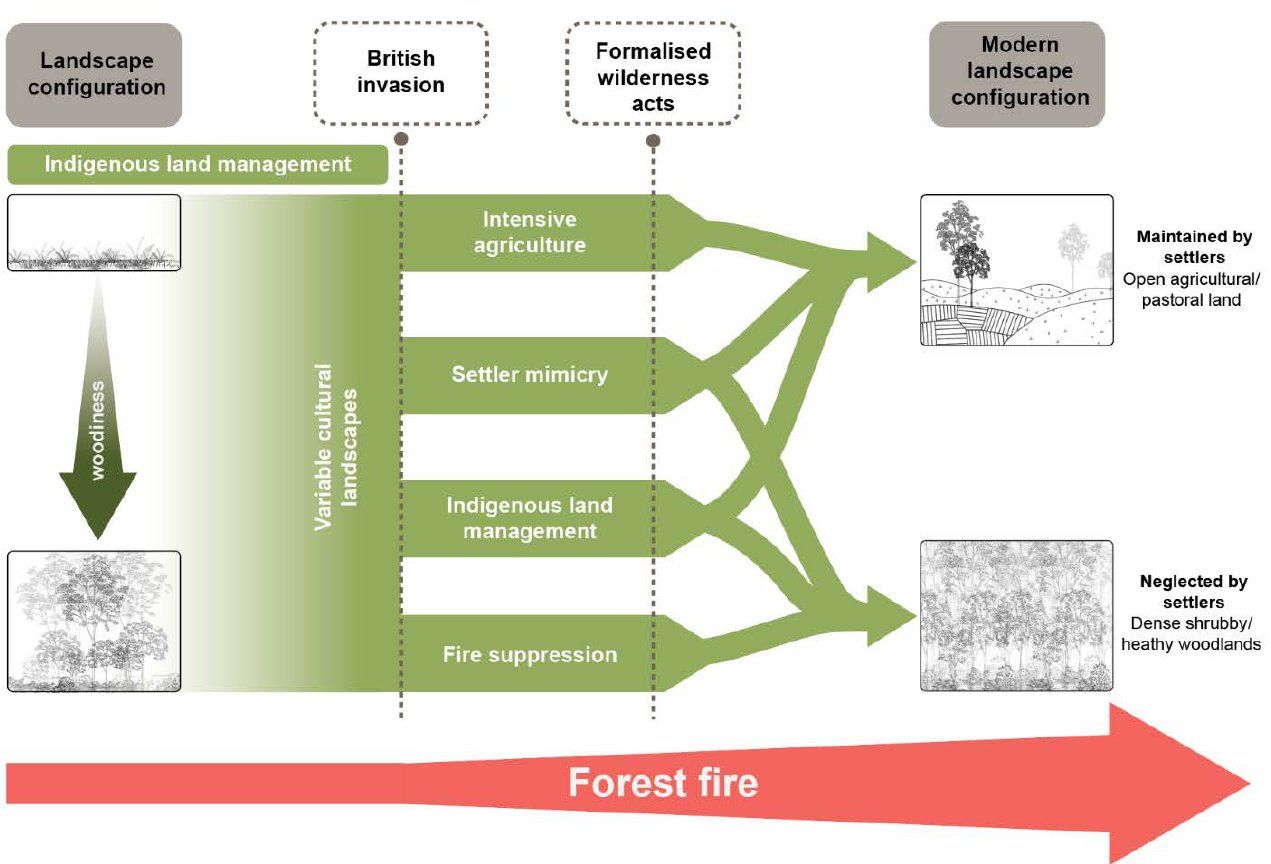
Figure 7. Conceptual diagram of how the landscape configuration and bushfire activity of southeast Australia has changed through time in response to the British Invasion and subsequent wilderness- inspired conservation legislation. Prior to British Invasion, Indigenous people managed variable cultural landscapes with fire across all parts of the region from open grasslands to closed forests in southeast Australia according to cultural protocols and economic objectives (left). After British Invasion management of landscape outside urban areas was fractured into four main approaches: (1) Intensive agriculture (taking advantage of open, grassy landscapes created and managed by Indigenous people, settlers concentrated agricultural activity and opened Country further); (2) Settler mimicry (in less open areas settlers mimicked cultural burning due to the recognition that Aboriginal managed landscapes were safer and more productive); (3) Indigenous land management (as removal and suppression of cultural burning was not uniform temporally and spatially, some parts of the landscape remained under Aboriginal management) and (4) Fire suppression (areas considered unsuitable for agriculture and/or settlement were neglected and fire suppression practices put in place) (center left) [34]. From the late 1950s legislation and conservation rooted in wilderness ideology further removed and suppressed active management of landscapes by Aboriginal and non-Aboriginal people (center right) facilitating a bifurcation of the landscape in to (1) open areas maintained by settlers as open pastoral or agricultural land and (2) neglected areas unmaintained by settlers as forest reserves, national parks and other areas where land was allowed to transition in to shrub-rich, dense woodlands in the absence of fire management (right) [41,75–77]. This confluence of factors has resulted in larger bushfires across southeast Australia since British Invasion (red arrow) [41]. For interpretation of the references to colour in this figure legend, the reader is referred to the web version of this article.